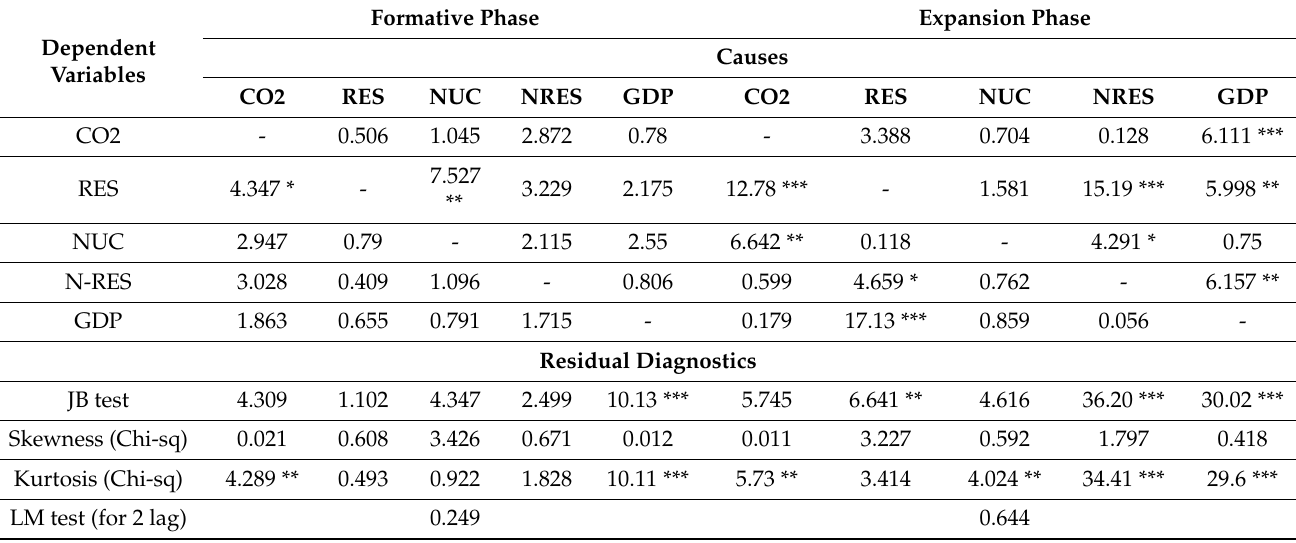
Table A3. Granger causality test results and residual diagnostics—Spain.